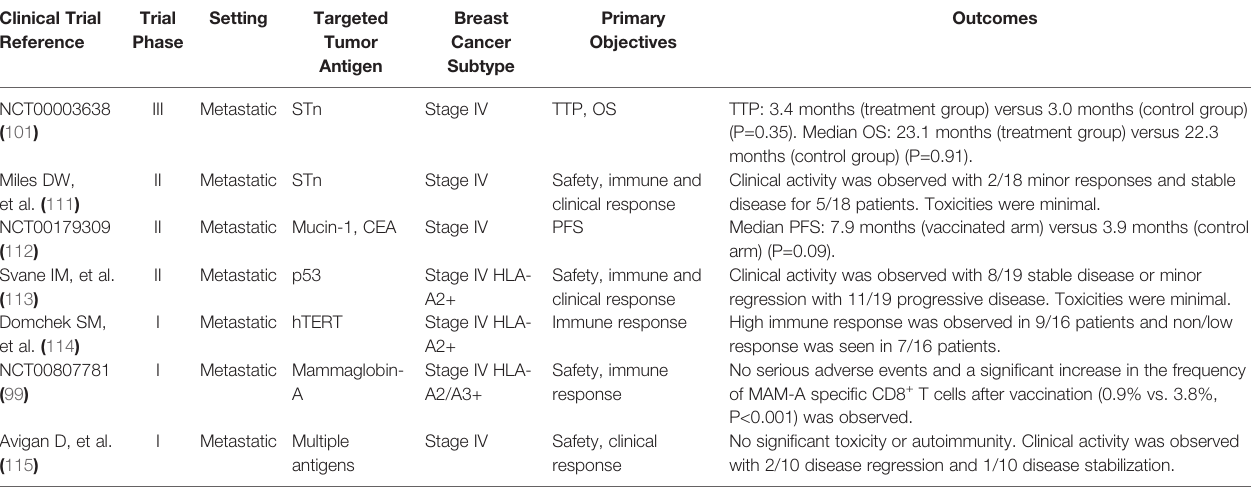
TABLE 3 | Major clinical trials on breast cancer vaccines targeting non-HER2-related antigens. Clinical Trial